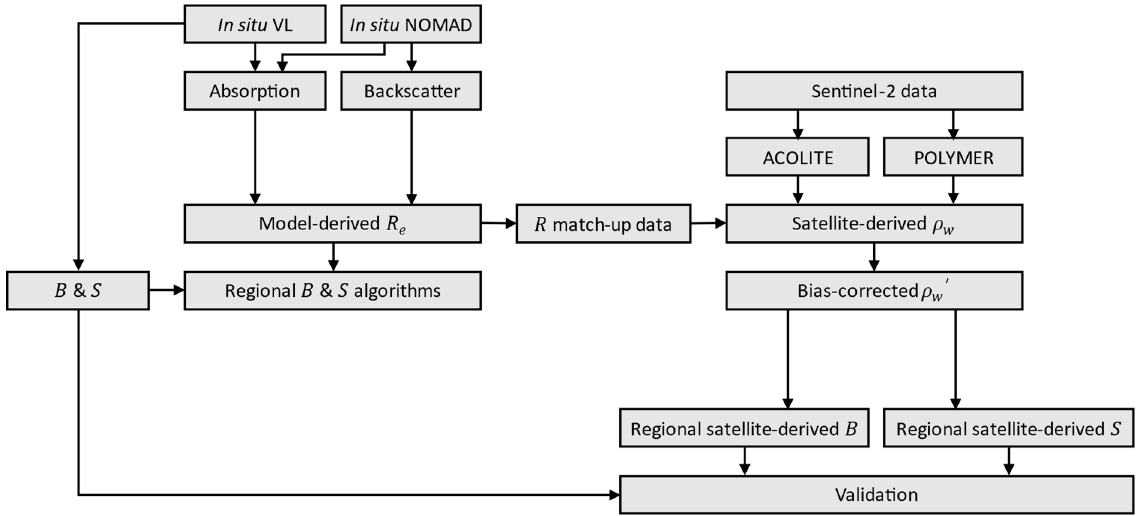
Figure 1. The present study workflow of the satellite-derived chlorophyll-a ( B ) and total suspended sediment ( S ) concentrations in Vembanad Lake. In situ measurements from the Vembanad Lake and NOMAD datasets were used to model absorption and back-scattering coefficients to obtain model-derived reflectances ( R e ). The R e was then used to develop regional chlorophyll-a ( B ) and total suspended matter ( S ) algorithms. The R e together with a satellite matchup dataset was used to correct satellite-derived ( ρ w ) reflectance, which were obtained from the ACOLITE- and POLYMER-processed Sentinel-2 images. The bias-corrected satellite reflectance ( ρ w (cid:48) ) was used as input to the regional satellite-derived B and S